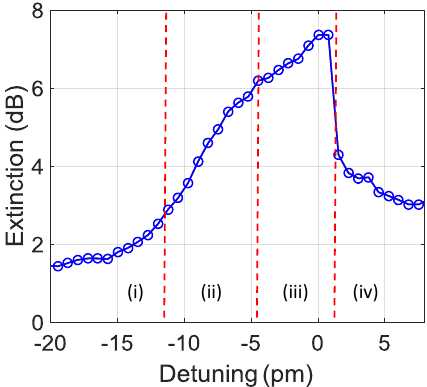
Figure 9. Measured extinction ratio of the device as a function of injection wavelength detuning from working point. (i) Injection on the blue side of the resonance; (ii) incomplete bistable switching; (iii) bistable switching; (iv) injection on the red side of the resonator past ‘switch off’